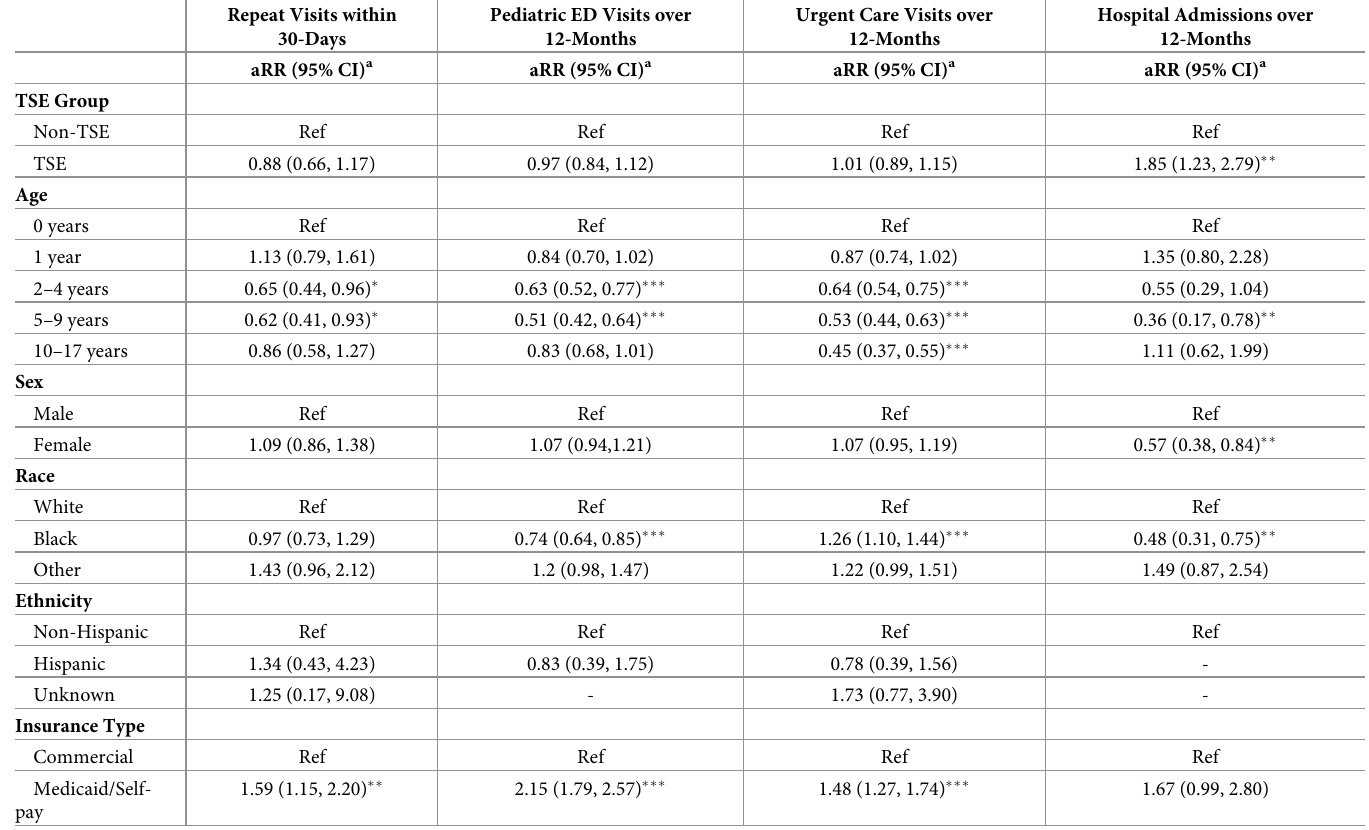
Table 3. Tobacco smoke exposure group status and healthcare utilization patterns over 12-months among nonsmoking children ages 0–17